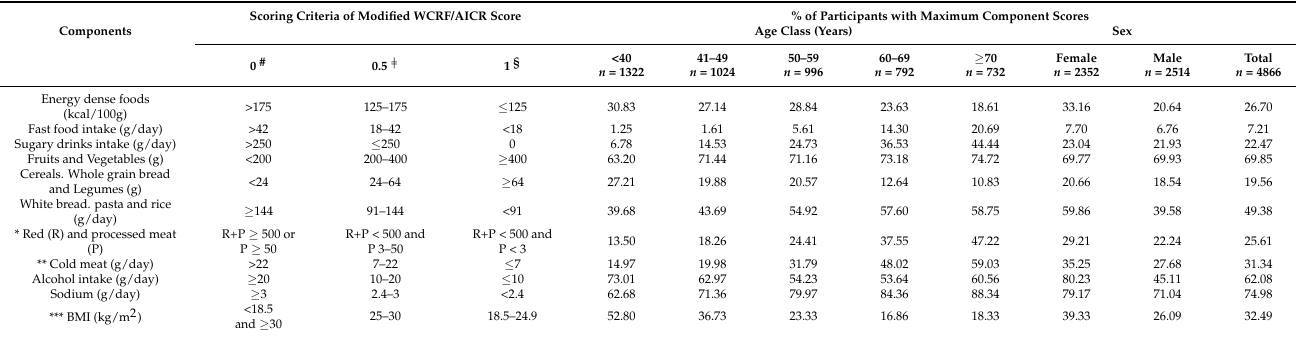
Table 1. Scoring criteria of the modified WCRF/AICR score components and percentage of participants with maximum score. ScoringCriteriaofModifiedWCRF/AICRScore %ofParticipantswithMaximumComponentScores Components